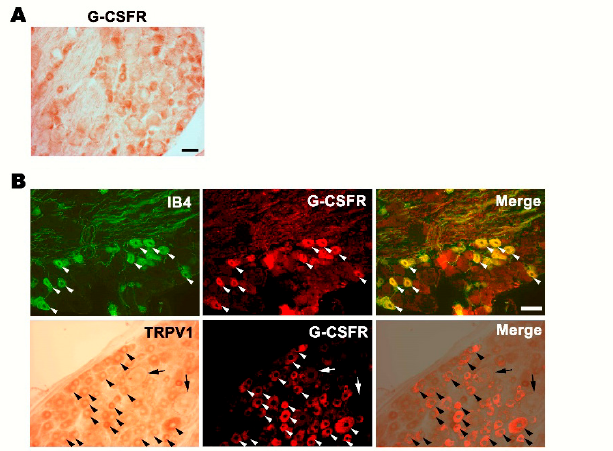
Figure 1. G-CSFR expressed in small- and medium-diameter DRG neurons. ( A ) G-CSFR immunohistochemistry. Bar = 50 μ m. ( B ) G-CSFR was expressed in small- and medium-diameter DRG neurons and nociceptive neurons in the DRG. DRG sections were double stained with IB4 and G-CSFR antibodies or TRPV1 and G-CSFR antibodies. Note that G-CSFR was co-expressed with nociceptive TRPV1 (arrowhead), but not in large-diameter DRG (arrow). Bar = 30 μ m.